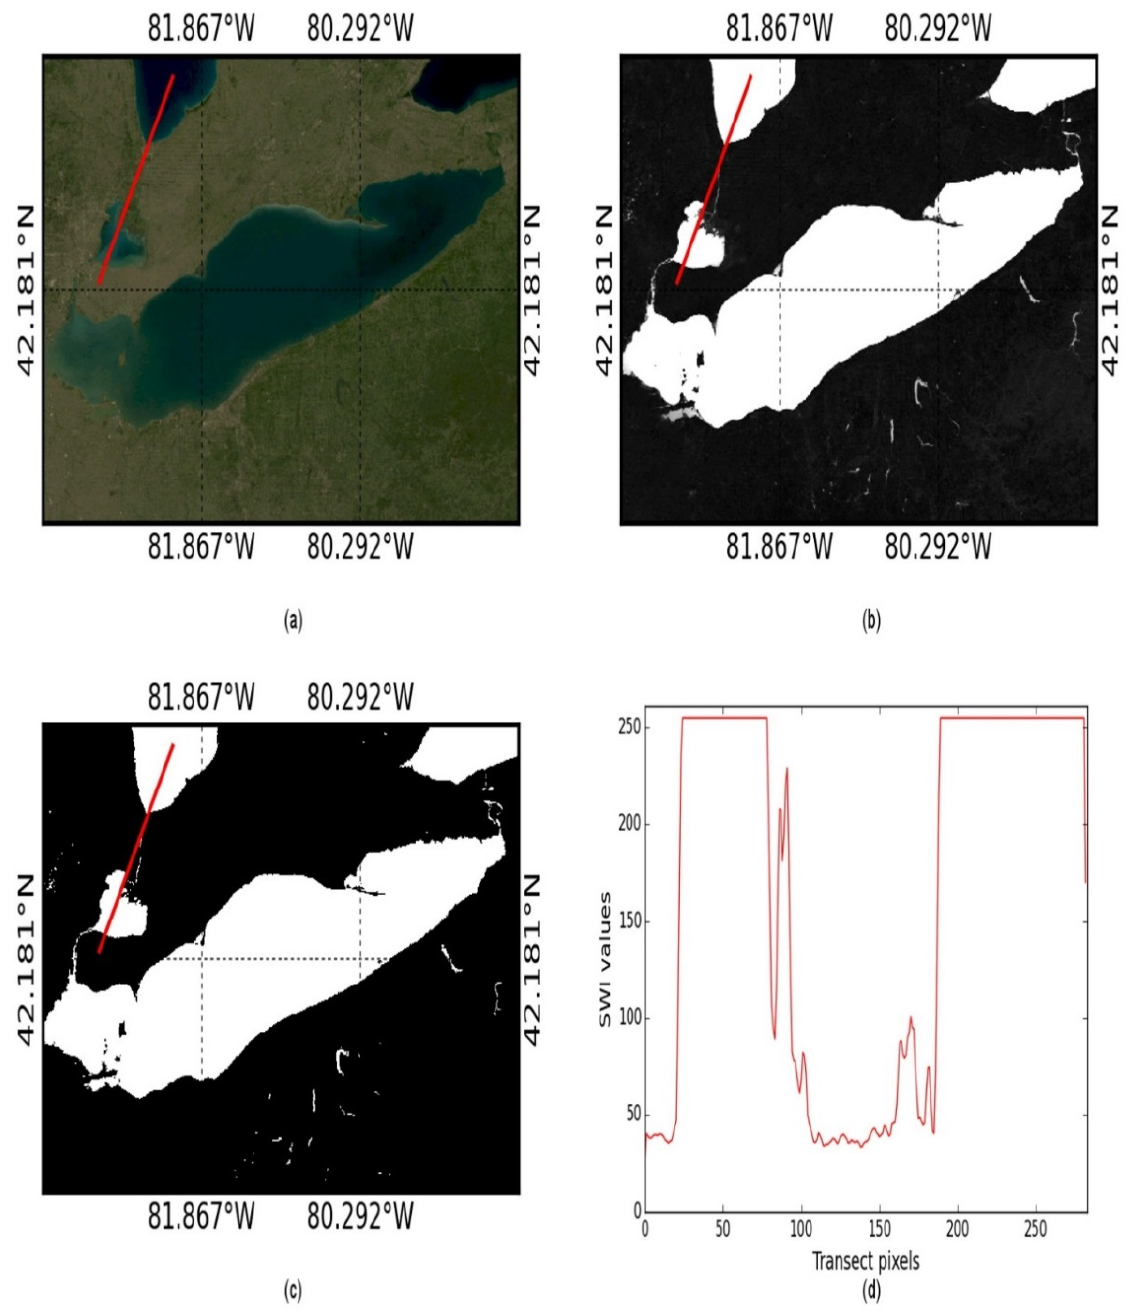
Figure 15. Performance of SWI based extraction of water cover in case of algal bloom: ( a ) MODIS true-color image, ( b ) SWI image, ( c ) Extracted water cover, ( d ) Profile plot of SWI along the red line